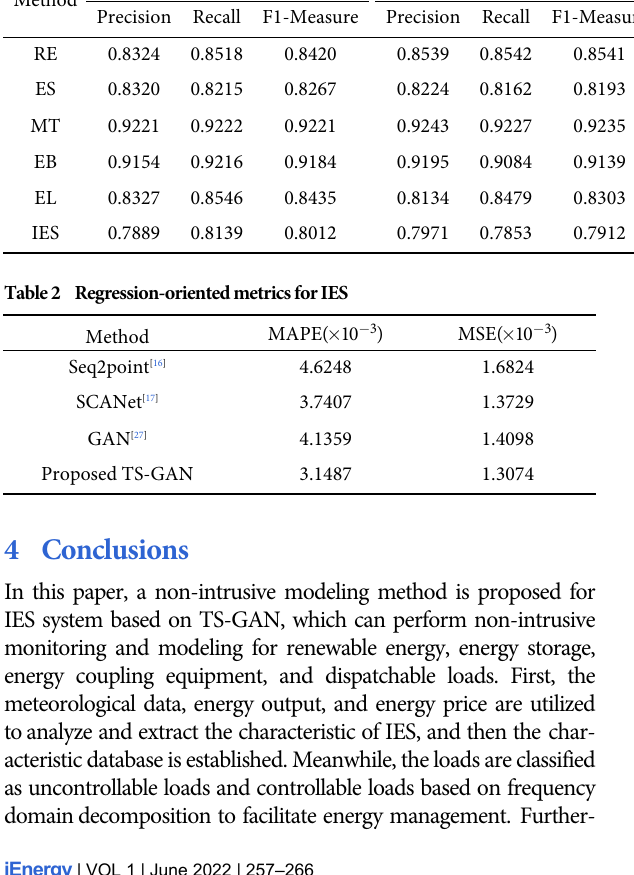
Table 1 Performance of the models for IES with 75% of training data CNN [13] Seq2point Method